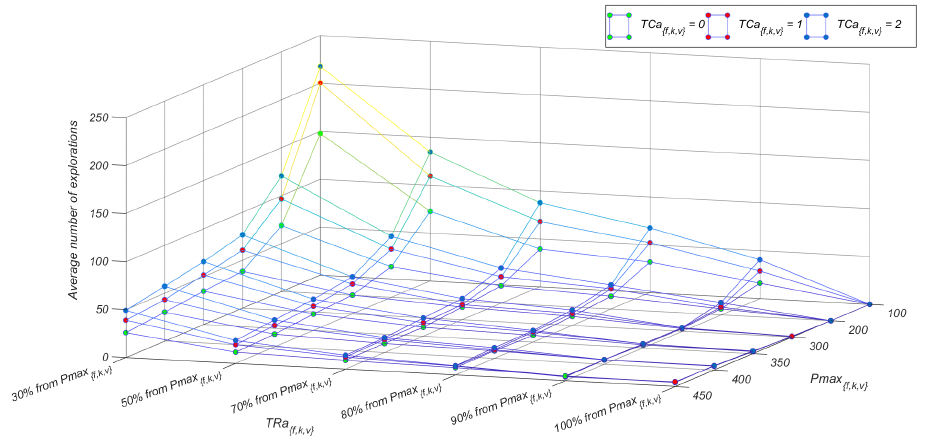
Figure 4. The number of explorations of the entire space in the 10,000th iteration: TPea { f , k , v } = 3 ∗ Pmax { f , k , v } .